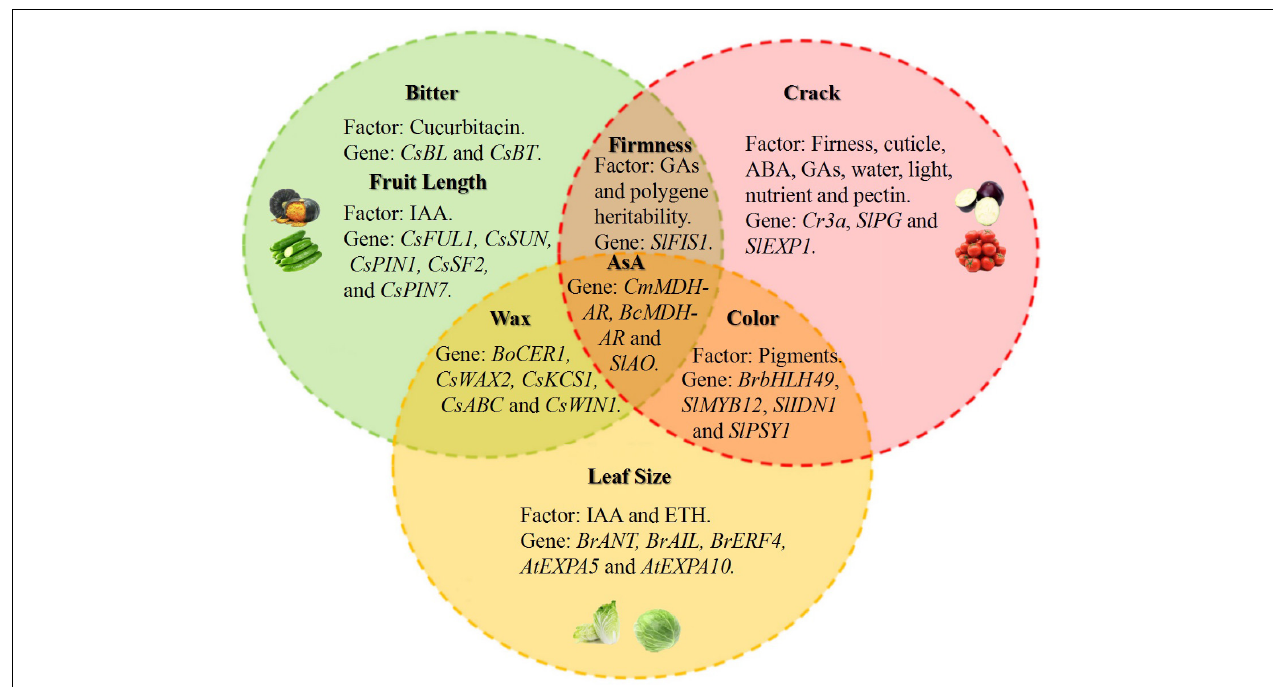
FIGURE 2 | Overview of the factors and genes related to vegetable quality, taking Brassicaceae , Solanaceae and Cucurbitaceae as examples. Phytohormones represent the main factor that can influence fruit length ( Cucurbitaceae ), leaf size ( Brassicaceae ), firmness ( Solanaceae ) and cracking ( Solanaceae ). Cucurbitacin is a unique substance of cucumbers that affects bitterness. Genes regulate different quality characteristics of vegetables, such as fruit length in cucumber ( CsFUL1 , CsSUN , CsPIN1 , CsPIN7 and CsSF2 ), cracks in tomato ( Cr3a , SlPG and SlEXP1 ) and leaf size in Chinese cabbage ( BrANT , BrAIL and BrERF4 ). Some homologous genes such as MDHAR also play similar roles in vegetable quality, which affects the content of AsA in non-heading Chinese cabbage and